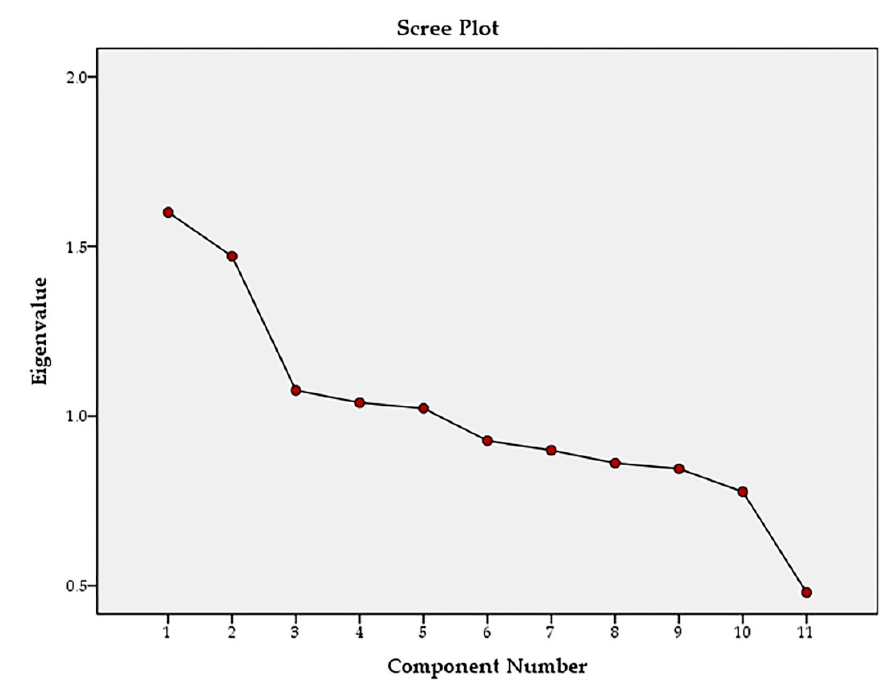
Figure 6. PCA (Scree plot) chart.